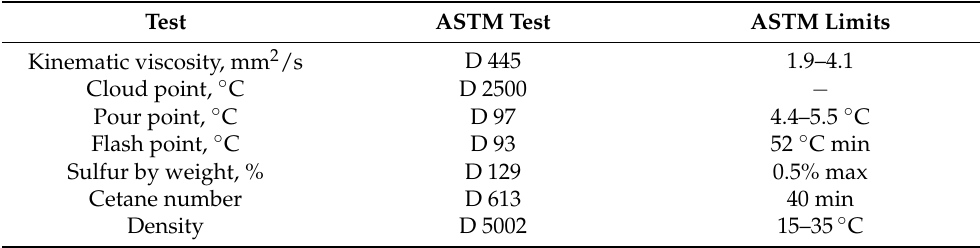
Table 1. Fuel properties test and limits [28].